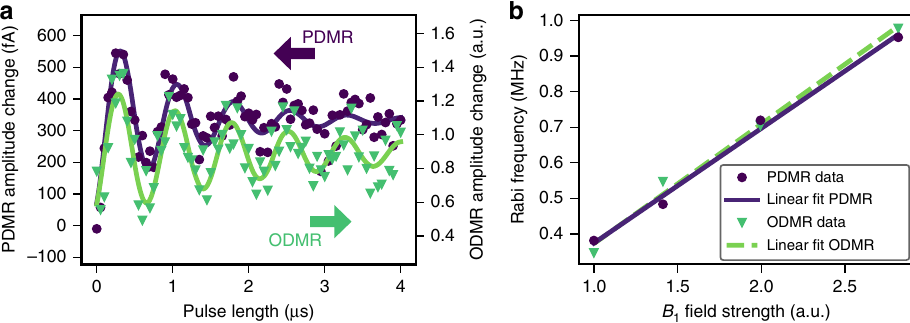
Fig. 4 Coherent measurements. a Electrically detected Rabi oscillation (purple dots) directly compared to optically detected Rabi oscillation (green triangles). Purple and green solid lines are exponentially decaying sine fi ts for PDMR and ODMR, respectively. b Driving fi eld strength dependence of Rabi oscillation frequency for optical (green triangles) and electrical readout (purple dots) with corresponding linear fi